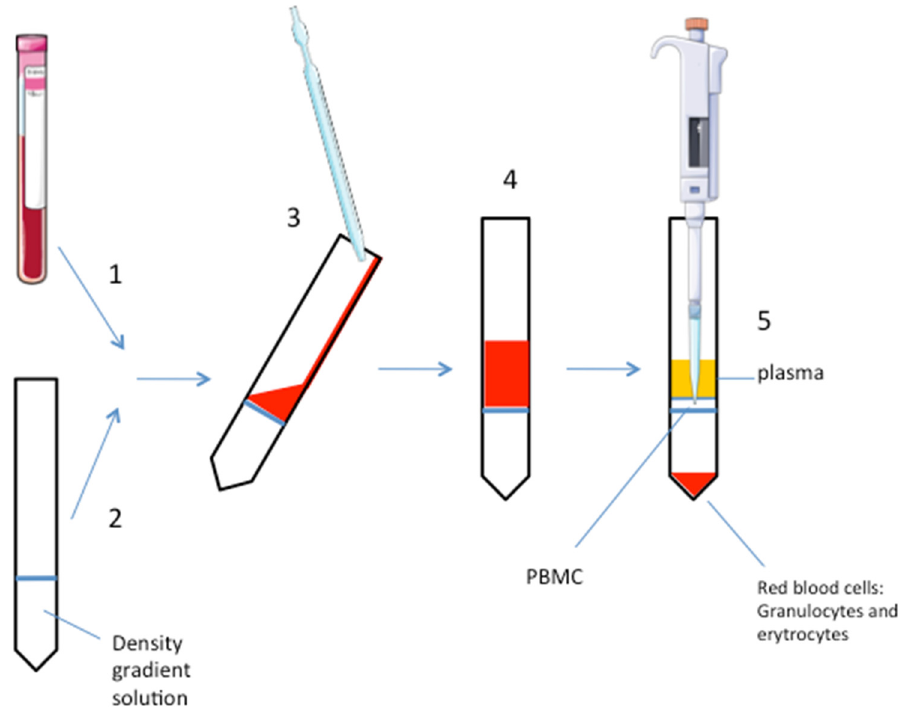
Figure 1. Schematic representation of the procedure. Numbers refer to the procedure steps in the text. The pipettes and the EDTA-tube are drawn using pictures from Servier Medical Art https://smart.servier.com/ under a Creative Commons Attribution 3.0 Unported License.